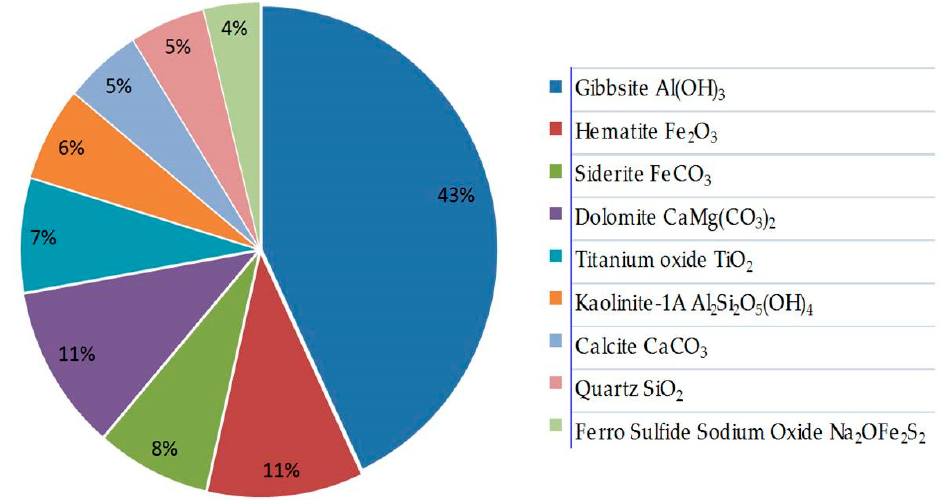
Figure 7. Phase composition of the coarse-grained fraction of bauxite.